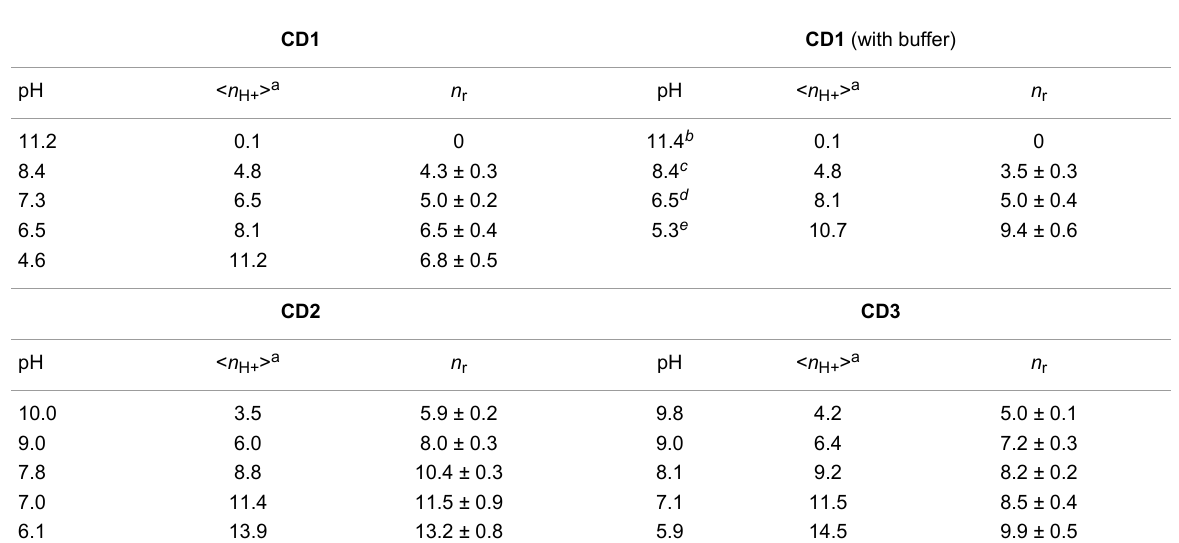
Table 1: n r Values for the AmCD–Alg interaction.